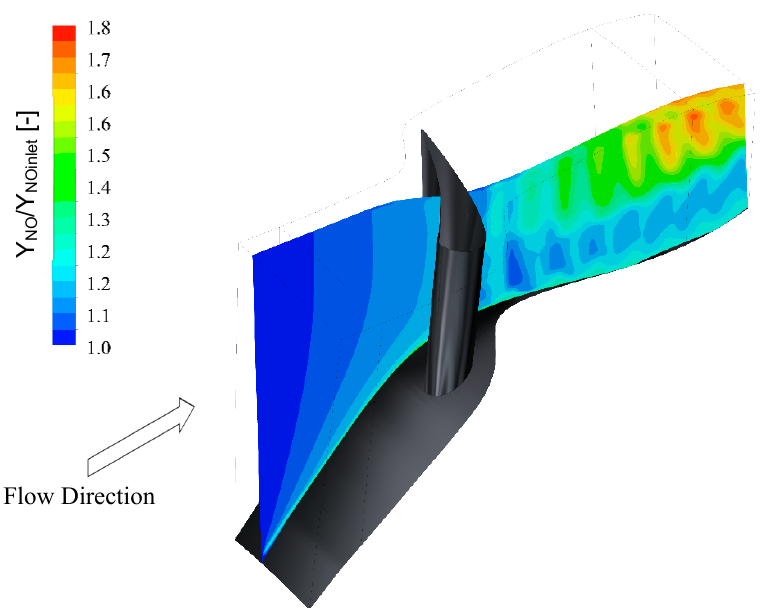
Figure 10. Local NO mass fraction, non-dimensionalised by inlet concentration for condition A on a plane, with the EDC approach and the POLIMI H 2 /CO mechanism.